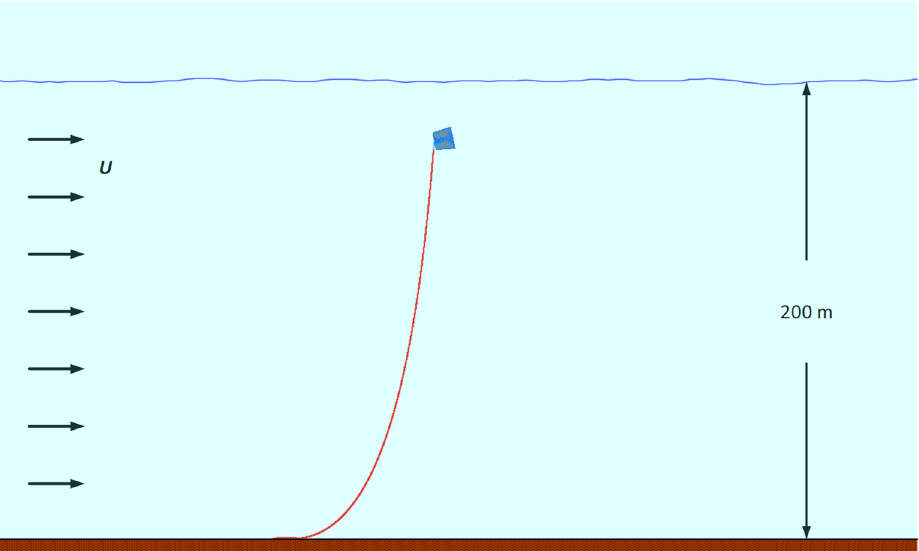
Figure 12. Illustration of single duct anchored on the seabed.